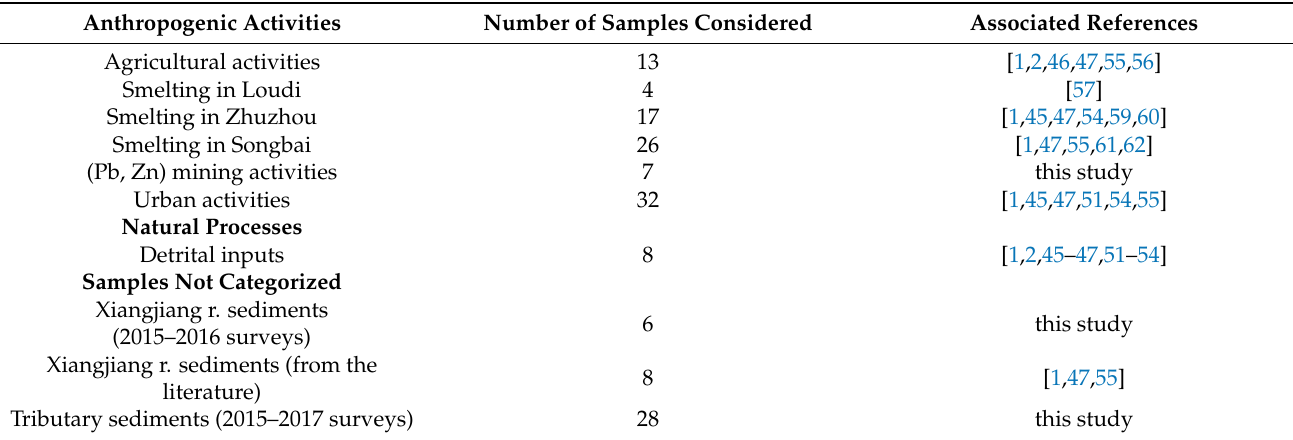
Table 2. Chemical categorization of sediment composition representative of potential anthropogenic activities and natural inputs in the Xiangjiang River basin associated with samples from this study and literature references ( n = 149). Anthropogenic Activities